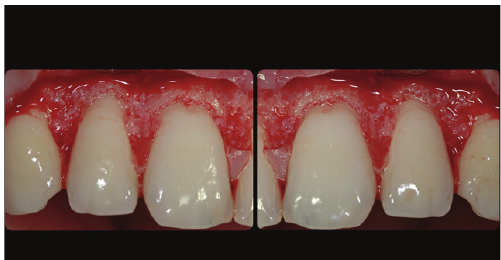
Figure 7: Bone crest after osseous resective surgery. Approximately 1mm of root surface was exposed.